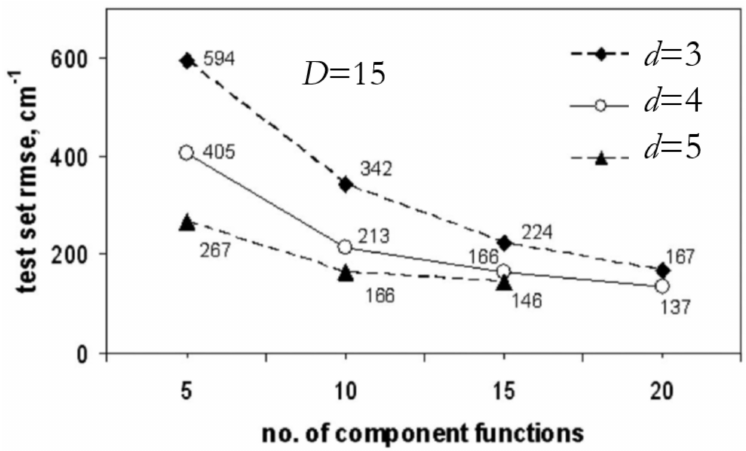
Figure 4. Test set root mean square error (rmse) of the interatomic potential of vinyl bromide as function of both the number and the dimensionality of terms of Red-RS-HDMR-NN. Reproduced with permission from [117]. Copyright 2010 American Institute of